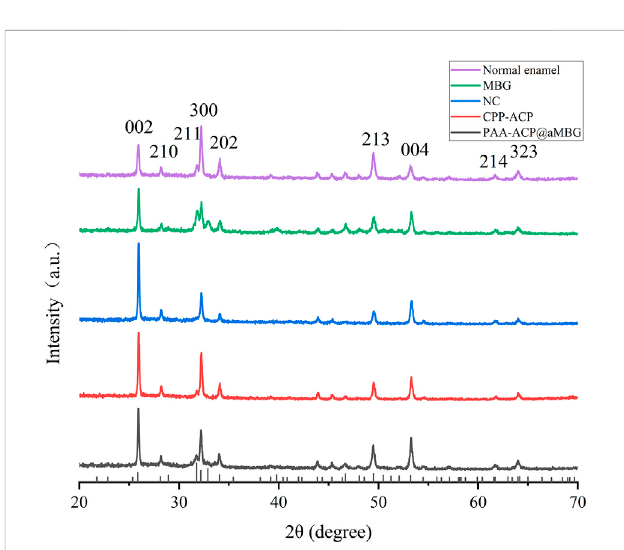
FIGURE 7 X-raydiffractionanalysisofthesamples.Atthebottomisastandard X-ray diffraction image of hydroxyapatite (JCPDS